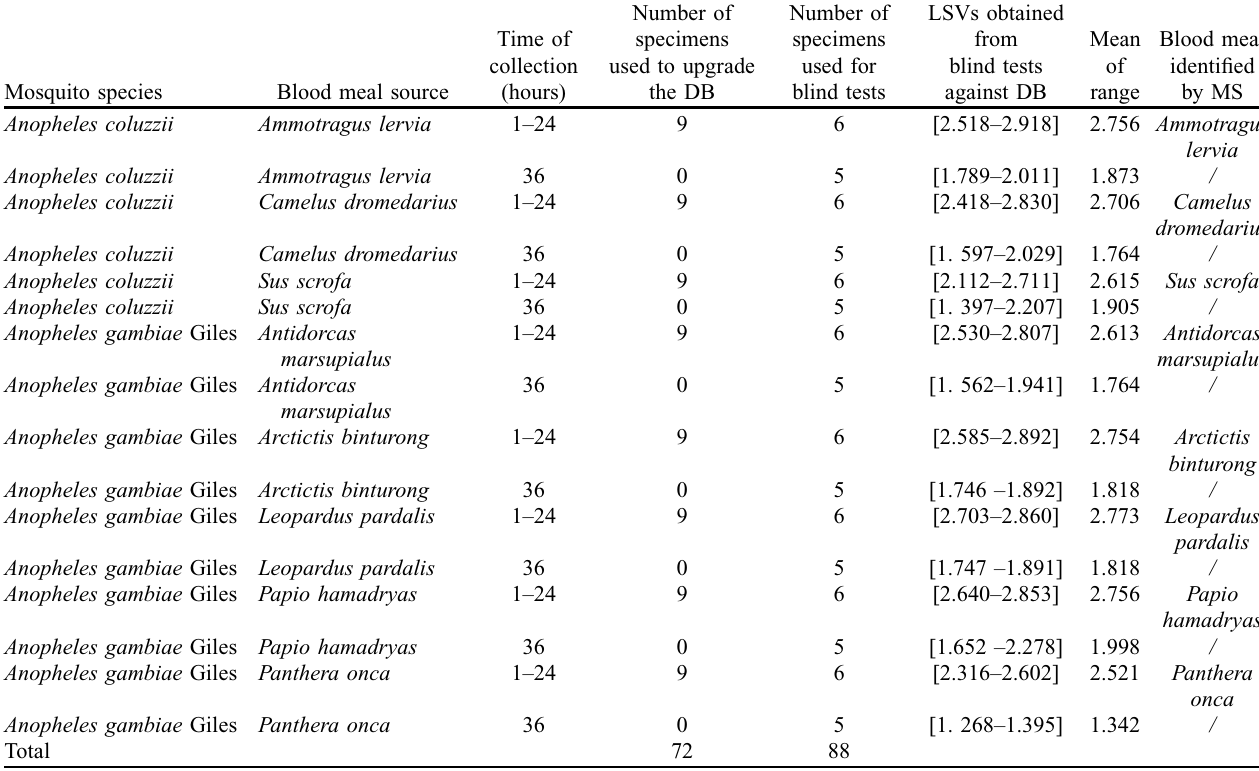
Table 1. Mosquito engorged abdomen spectra used for the home-made database and identification according to post-feeding period.